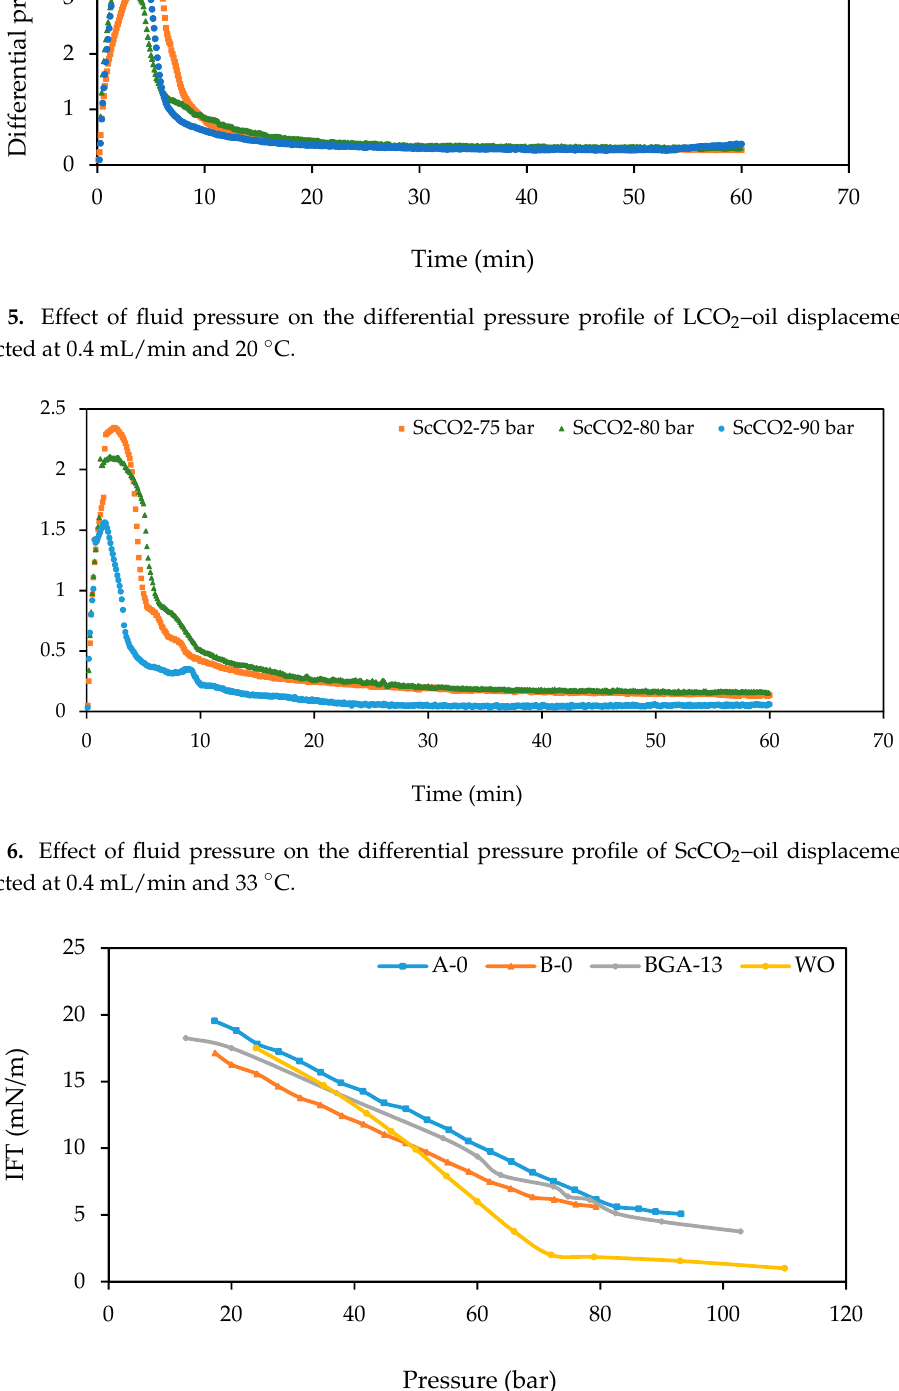
Figure 8. Re-imbibition process in fine-grained rocks (schematic re-imbibition): ( A ) drainage, ( B ) an initially water-saturated sample, ( C ) gas breakthrough, and ( D ) re-imbibition [69]. 3.1.2. The Effect of Temperature on the Differential Pressure Profile of CO 2 –Oil Displacements Figures 9–12 show the effect of increasing experimental temperature on the differential pressure profile of gaseous, liquid, and supercritical CO 2 –oil drainage displacements. The results reveal that increasing temperature led to a reduction in the differential pressure for both subcritical and supercritical displacements. The increase in temperature resulted in the appearance of differential pressure (PD) oscillations for the gaseous and supercritical CO 2 displacements but not for the liquid CO 2 displacements. The highest reduction in the differential pressure profile as temperature increased occurred in the high-fluid-pressure and then low-fluid-pressure gaseous CO 2 displacements, followed by supercritical CO 2 and then finally by liquid CO 2 displacements.